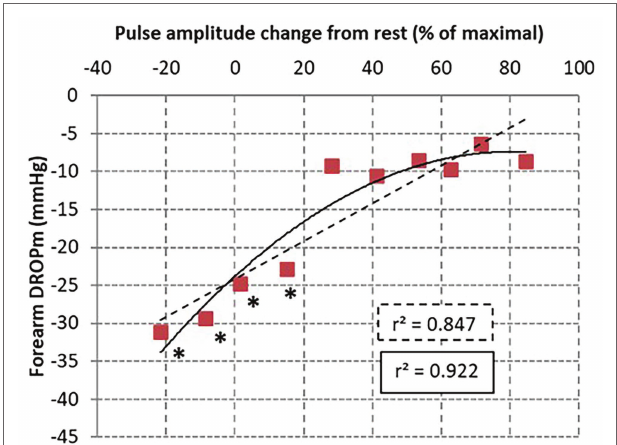
FIGURE 4 | Scatterplot of DROPm results from transcutaneous oxygen pressure recordings for each decile of pulse amplitude (PA) changes in the 110 arms tested. The relationship was tested with a linear (dotted line) and second degree polynomial models. As shown, the highest coefficient of determinations was found for the non-linear model. * is p < 0.05 from the highest